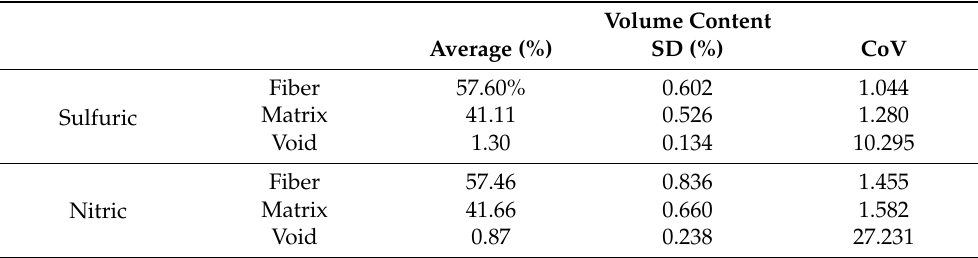
Table 2. Statistics of sample tested by acid